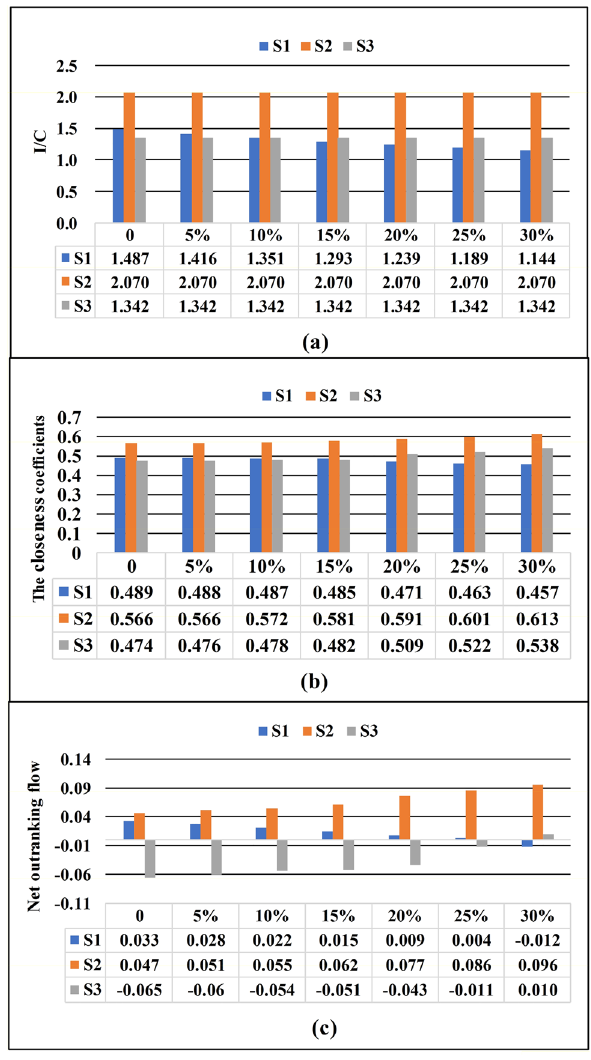
Figure 7. The final results for case 2 using the ( a ) CBA, ( b ) TOPSIS, ( c ) PROMETHEE